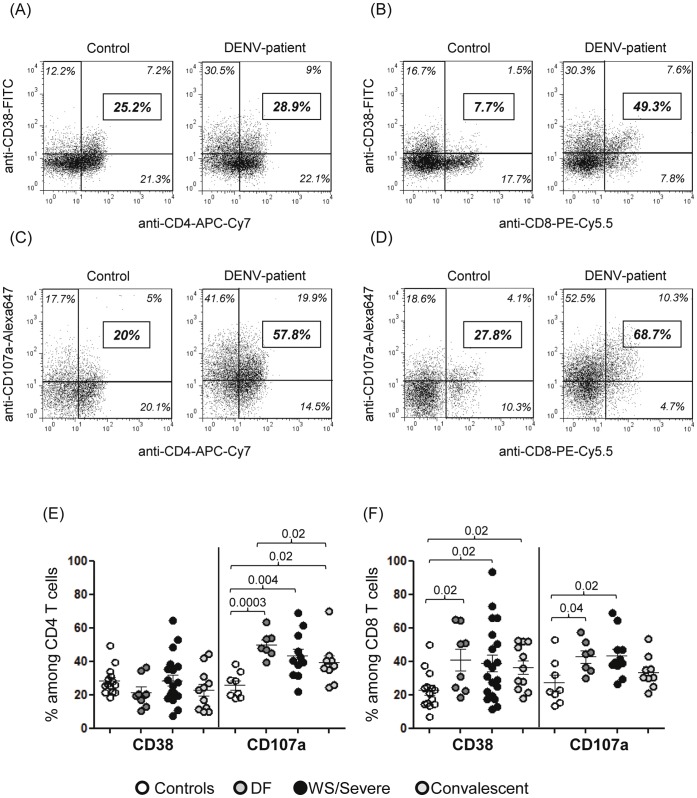
Phenotype of CD4 and CD8 T cells from DENV-patients.Representative flow cytometry dot plots comparing the frequency of CD38+ among CD4 and CD8 T cells (A–B) and CD107a+ among CD4 and CD8 T cells (C–D) and in one healthy control and one DENV-patient. The values in italics in each region of the quadrants indicate the values of the cells’ frequency of the quadrants. The bold-, italic and framed numbers on the right indicate the percentages of marker among T cells. Appropriate matched isotype control antibodies were used to discriminate between positive and negative populations. (E) Percentage of CD38 or CD107a-expressing among CD4+; (F) Percentage of CD38 or CD107a-expressing among CD8+ T cells. Horizontal bars indicate the mean values, standard deviation for each population. The Mann–Whitney U-test was used to analyze differences between control and patient groups. Statistically significant P values for differences between patients and controls are shown above the figures.